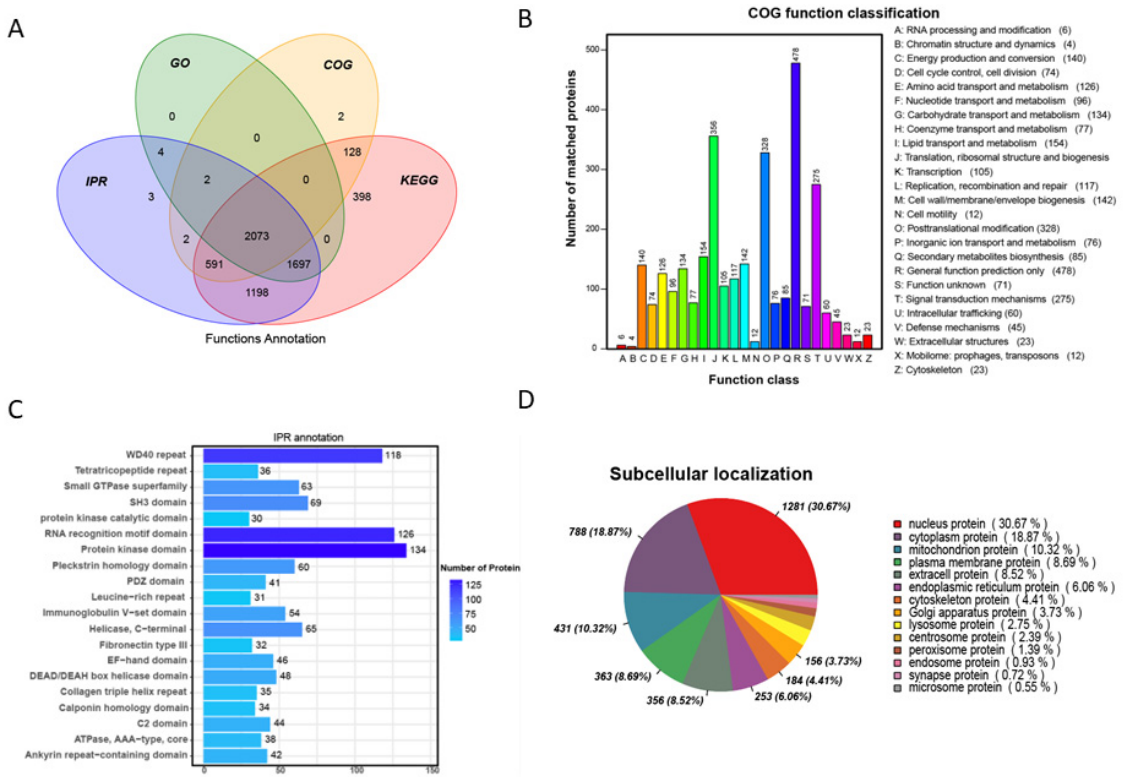
Figure 2. Functional annotation analysis of all samples. ( A ) Wayne analysis of annotated proteins using different databases. ( B ) COG functional classification of all matched proteins. ( C ) IPR annota- tion analysis of all samples. ( D ) The subcellular localization of all samples. GO gene ontology, COG: Cluster of Orthologous Groups, IPR: InterPro, KEGG: Kyoto Encyclopedia of Genes and Genomes.